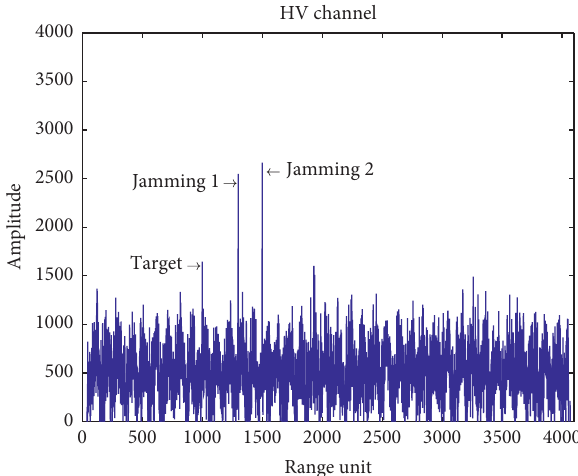
Figure 4: Echo signal received by the vertical polarization sum channel with active deception jamming.